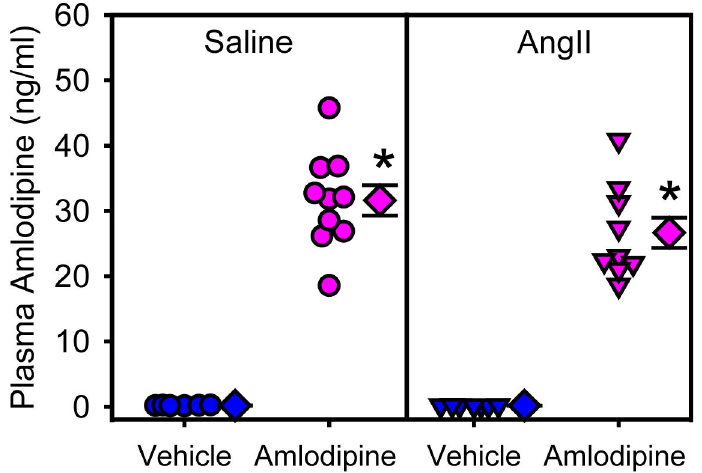
Figure 1. Plasma concentrations of amlodipine. Plasma concentrations of amlodipine were measured at the end of study. Circles and triangles represent individual mice, diamonds are means of groups, and error bars are SEMs. * denotes P<0.0001 comparing amlodipine groups with saline + vehicle and AngII + vehicle groups by two way ANOVA. doi: